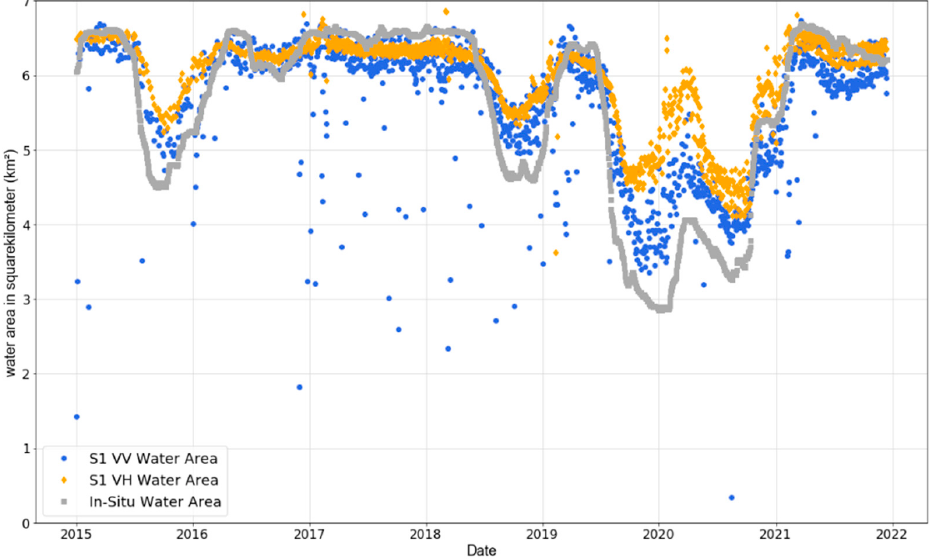
Figure 7. Time series for the water area in VV and VH polarization and in situ data for the Quitzdorf reservoir. Time period from 1 January 2015 to 31 December 2021.